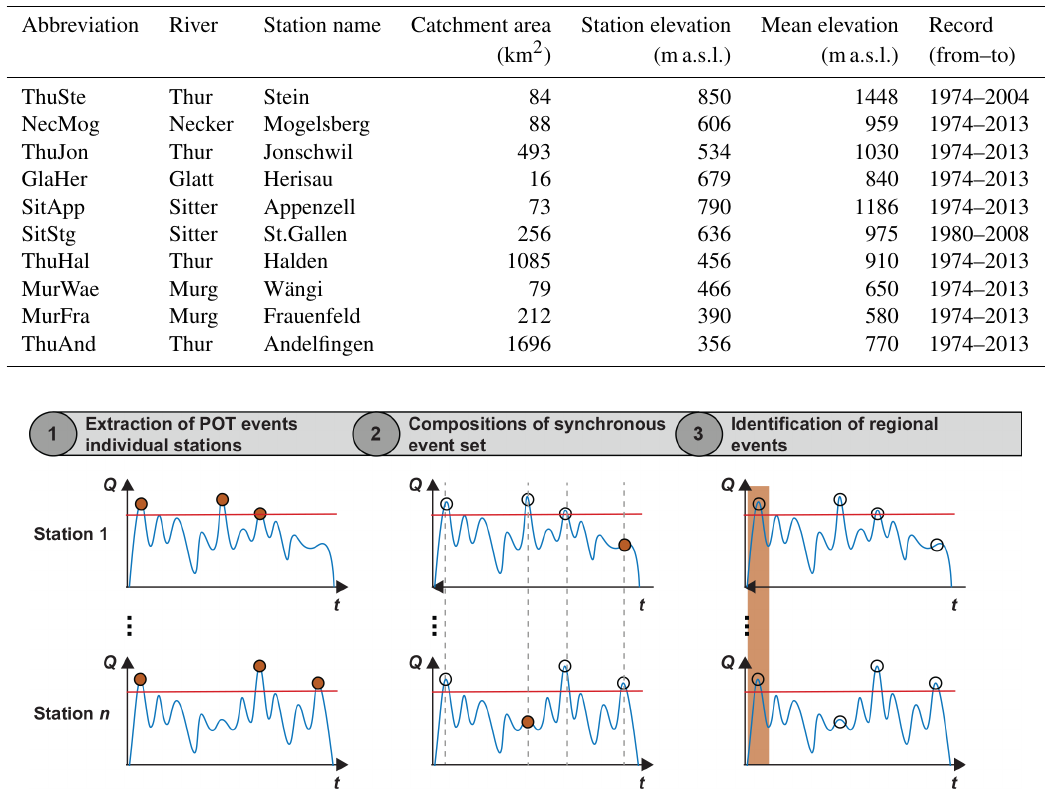
Table 1. Catchments used for fitting the spatial dependence models tested in this study. The station abbreviation is given together with the full name of the river and the gauging station, the catchment area, the station elevation, the mean elevation of the catchment, and the record period.